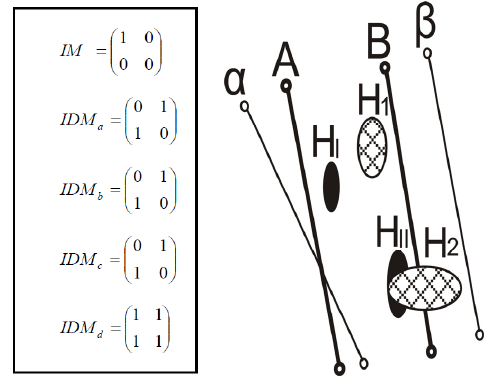
Figure 6. The DSL4IM and IDM of one typical topological relation between two DSL-SRMs.